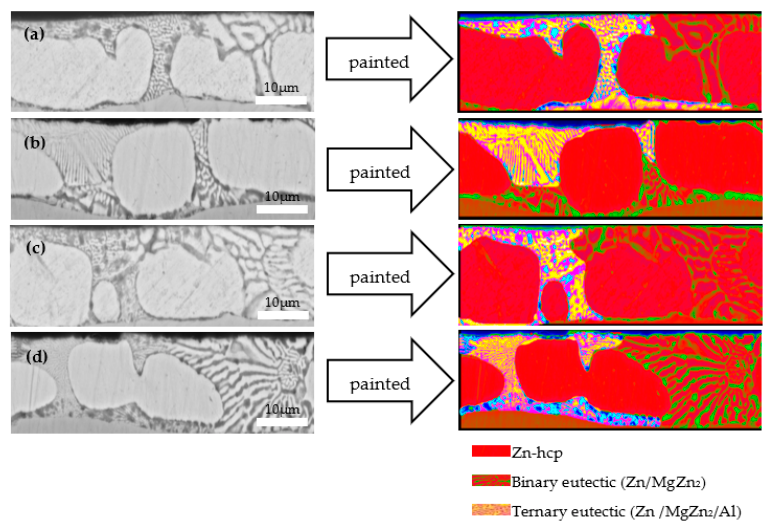
Figure 4. SEM photos of cross-section and ImageJ alloy phase dyeing photos of ( a ) Zn-1.0Al-1.0Mg,